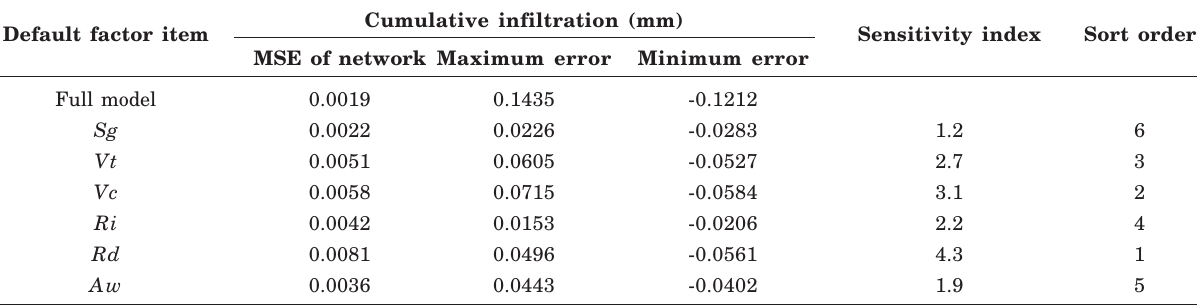
Table 3 Validation results of the default factor test (Iterations: 10 4 )